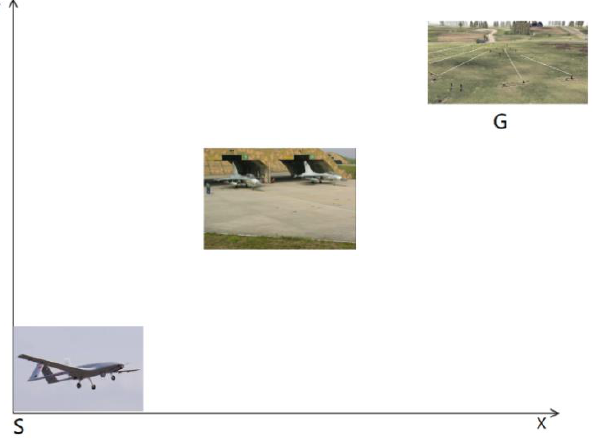
Figure 2. Air combat field.